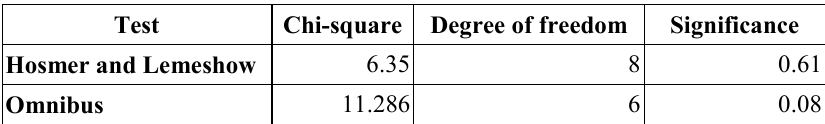
Table 6. Hosmer and Lemeshow Goodness Test and Omnibus Test